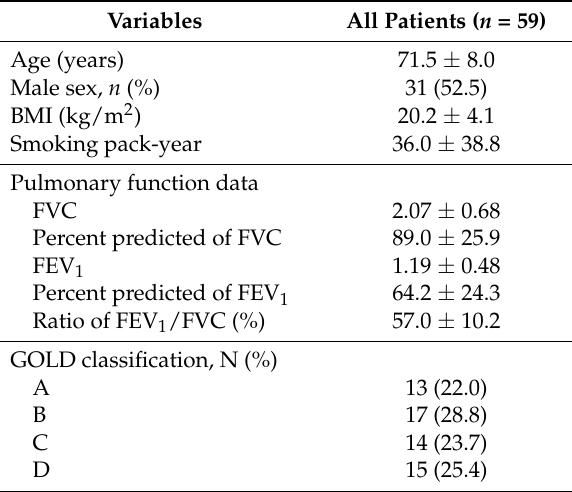
Table 1. Baseline characteristics of patients in this